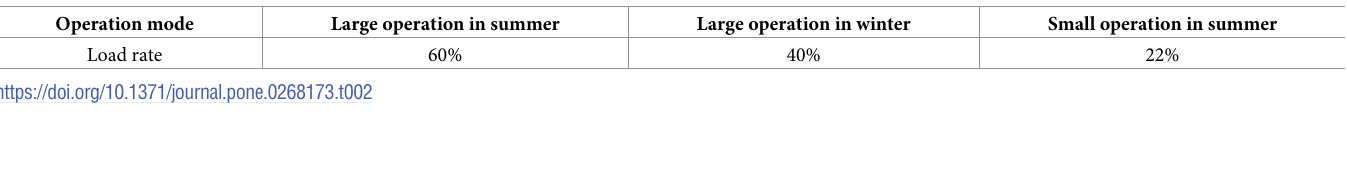
Table 2. Load rate value of the